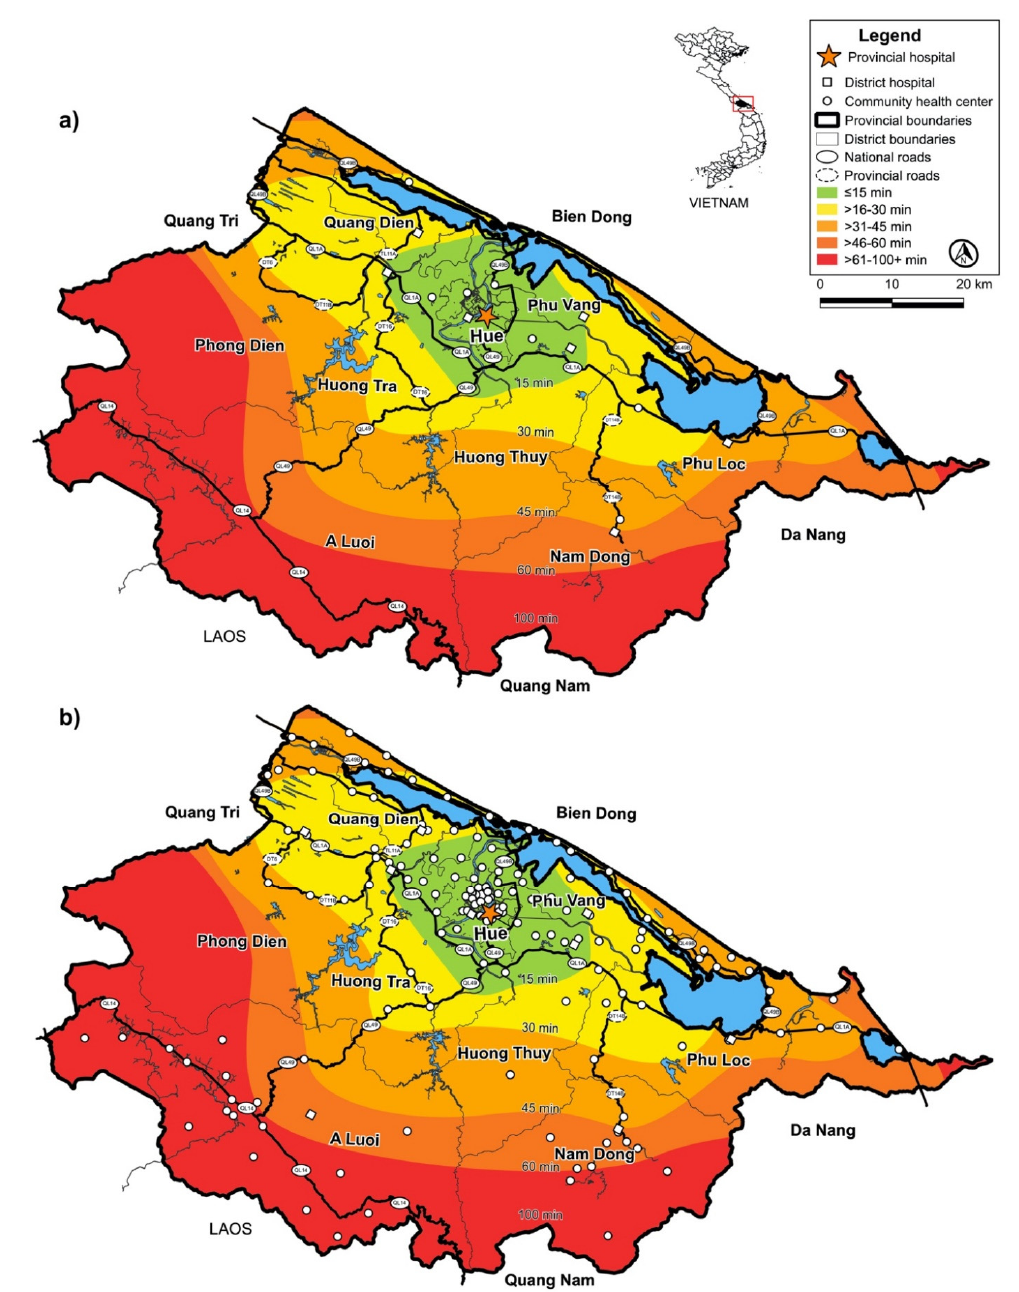
Figure 3. ( a ) SWN time contours of surveyed health facilities. Thua Thien Hue Province SWN time contours ( top ) illustrate the temporal and geospatial domains for the community health centers and